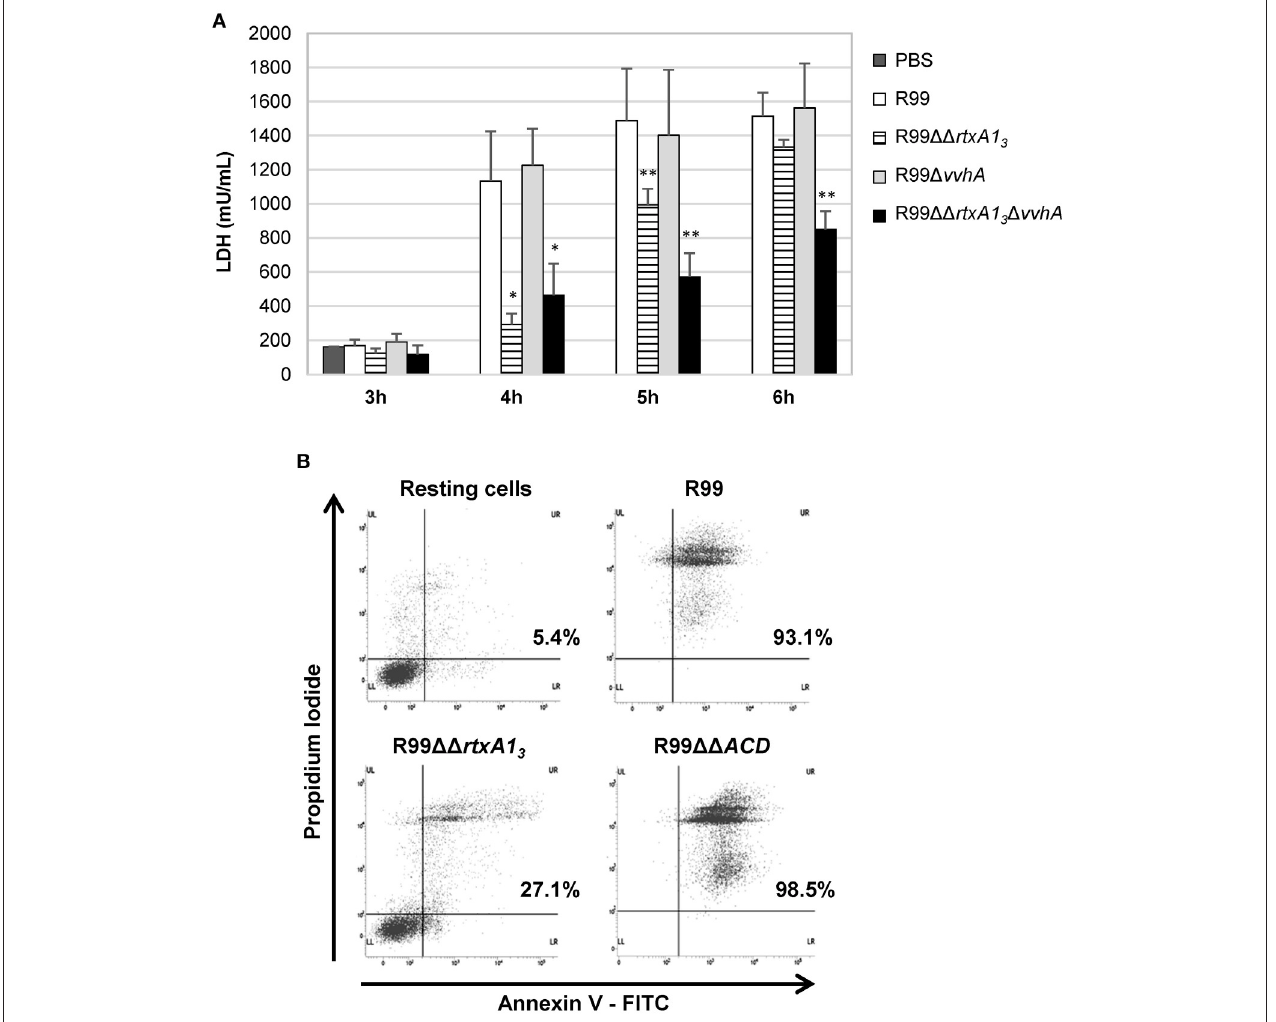
FIGURE 2 | V. vulnificus rtxA1 3 gene is involved in cell damage induction and apoptosis in human monocytes. (A) Live cells of V. vulnificus R99, R99 11 rtxA1 3 mutant, R99 1 vvha mutant, and the double R99 11 rtxA1 3 1 vvhA mutant, were added at a MOI of 2 to ECV304 cells. Cells were incubated with the bacteria for the appropriate time intervals and then cell culture supernatants were collected and assessed for lactate dehydrogenase (LDH) levels. Data represent mean values ± standard deviation from three independent experiments. The significance of the differences was determined using the Student’s two-tailed t -test; * p < 0.05 and ** p < 0.01 compared with R99 infected cells. (B) THP-1 cells were infected for 3.5 h with V. vulnificus R99, R99 11 rtxA1 3 , and R99 11 ACD strains, at a MOI of 10. The induction of apoptosis/necrosis was then measured by Flow Cytometry using the FITC Annexin V Apoptosis Detection Kit I. Results show histograms from one representative experiment of